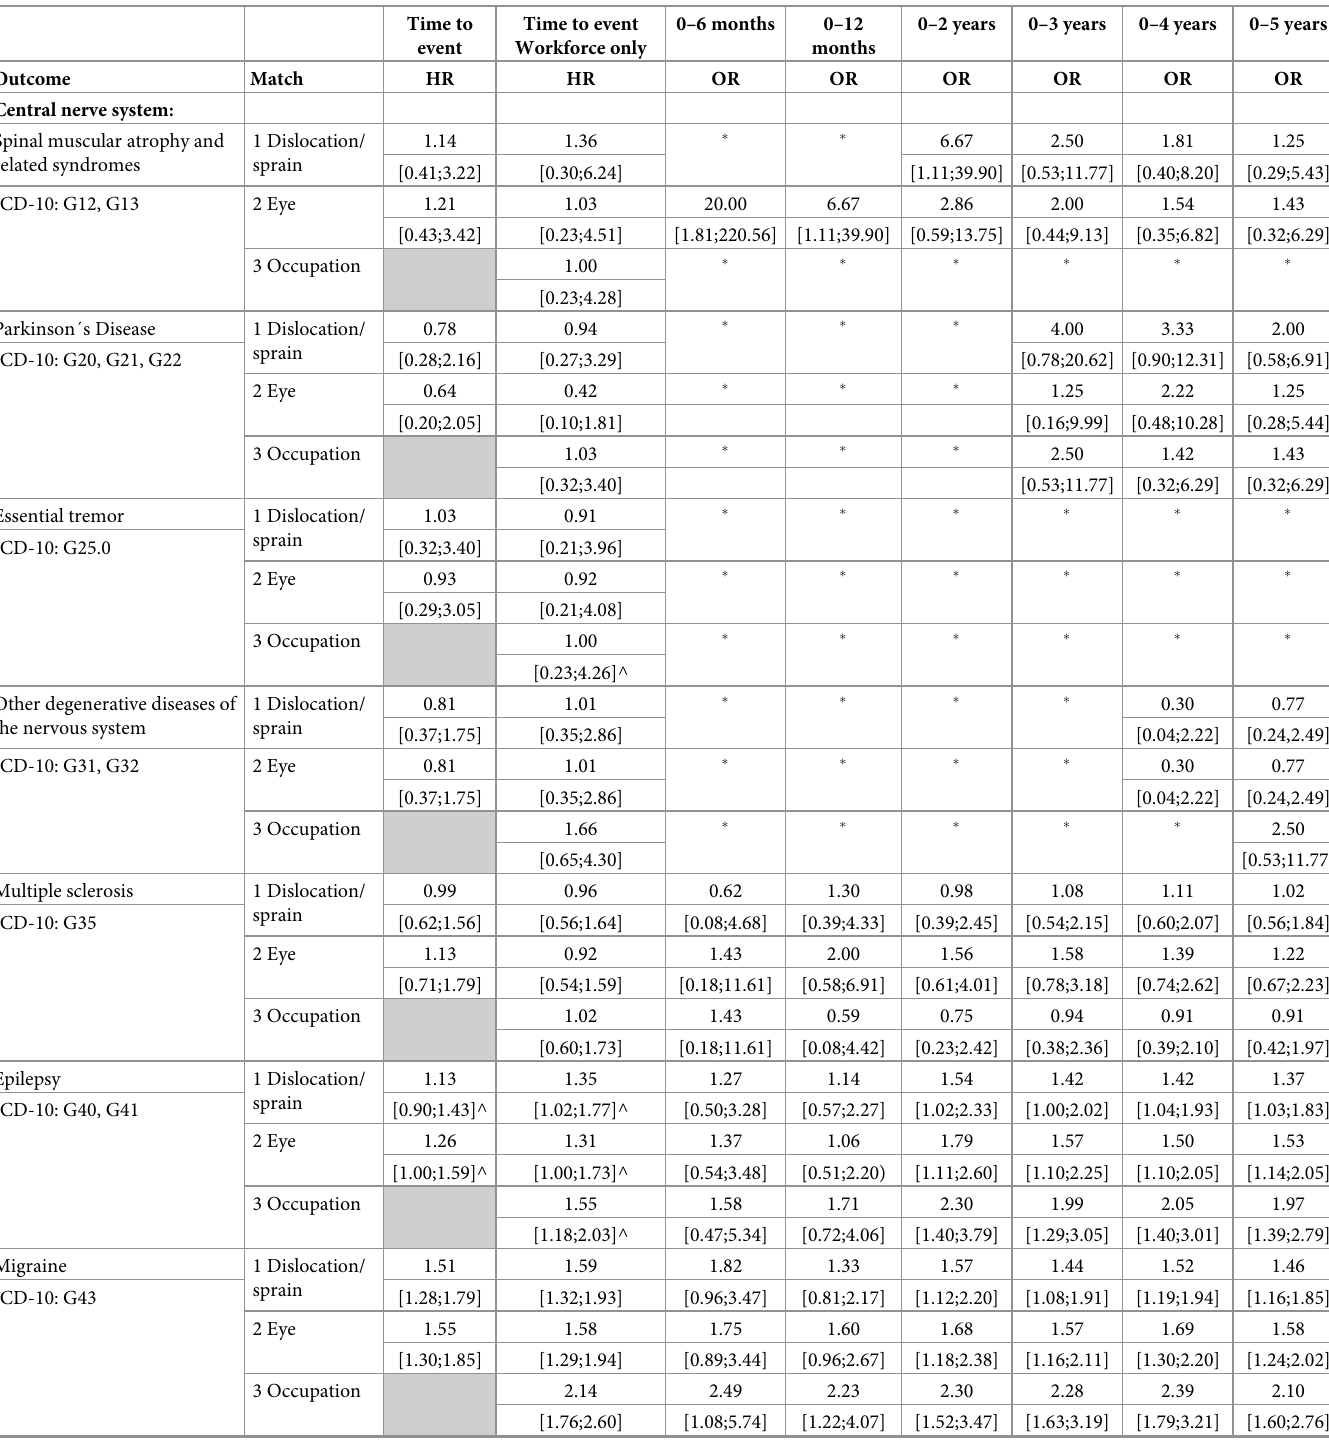
Table 2. Associations between electrical injuries and outcomes for the whole study period and in time intervals (electrical injuries matched in three different